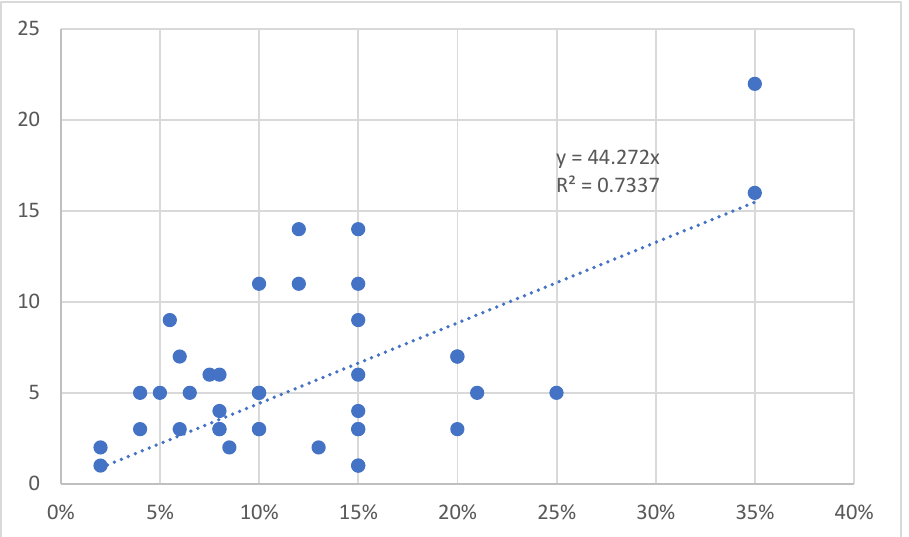
Figure 5. Correlation between number of dressings and extent of the lesion.